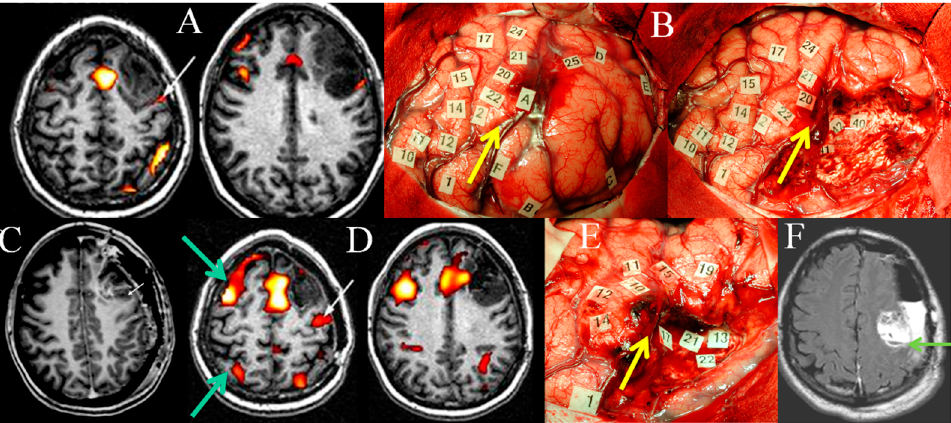
Figure 2. Illustration of remapping in the same patient demonstrated by serial FNI and DEM mappings. ( A ) Preoperative language fMRI in a patient without deficit, bearing an LGG within the left premotor area: language activation is near the posterior part of the glioma, within the precentral sulcus (white arrow). ( B ) Intrasurgical views before (left) and after (right) glioma resection, delineated by letter tags. DEM shows a reshaping of the functional maps, with a recruitment of perilesional language sites, enabling a subtotal resection with nevertheless a posterior residue due to the involvement of critical areas (number tags). The yellow arrow shows the precentral sulcus, demonstrating that it was not possible to remove the portion of the LGG involving the precentral gyrus. ( C ) Immediate postoperative enhanced T1-weighted MRI showing the tumoral residue (small arrow), in front of the precentral gyrus. ( D ) Postoperative language fMRI 4 years after the first fMRI, revealing a recruitment of the contra-lateral hemisphere (green arrows), and a posterior displacement of a left activation previously located within the precentral sulcus, which now shifted within the central sulcus (white arrow). ( E ) Intraoperative view during the second surgery, confirming the functional remapping, and making possible a more extensive glioma resection posteriorly, with no permanent deficit. Again, the yellow arrow shows the precentral sulcus, demonstrating that, this time, it was possible to remove a part of the glioma involving the precentral gyrus. ( F ) Immediate postsurgical axial FLAIR-weighted MRI (3 h after operation) confirming the increase of the extent of resection within the left precentral gyrus, thanks to functional reshaping (the green arrow shows the central sulcus). The patient resumed a normal social and professional life 3 months after reoperation, with no adjuvant oncological treatment. (The images are modified from